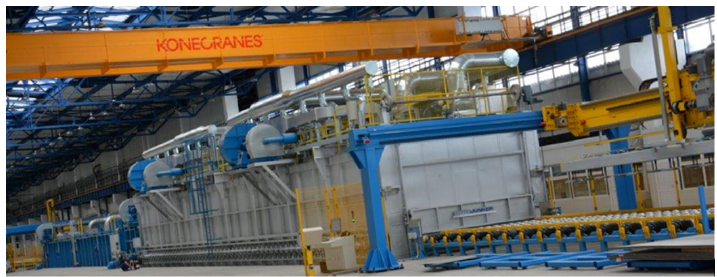
Figure 1. The independent equipment for the research of aluminium alloy quenching process.